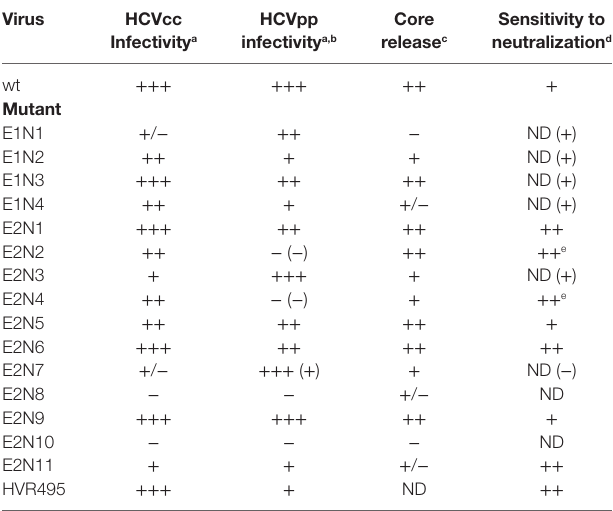
TAbLe 1 | Summary of the features of HCV glycosylation mutants [adapted from Helle et al. (92)].